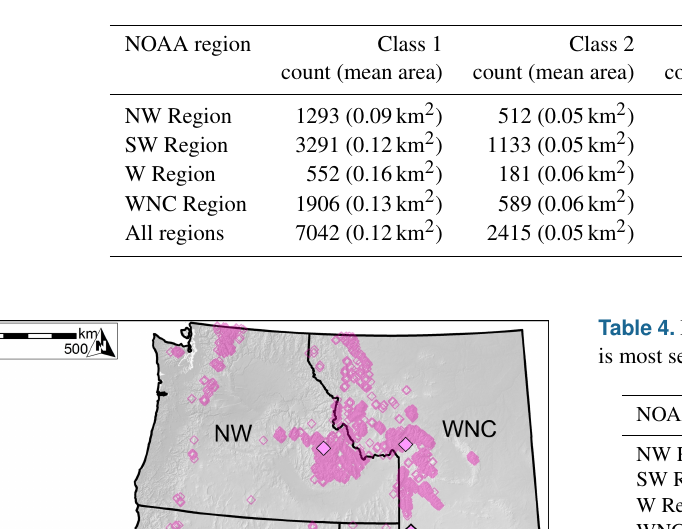
Table 2. Rock glacier counts by NOAA climate region. The SW and WNC regions account for nearly 73% of rock glaciers identified.